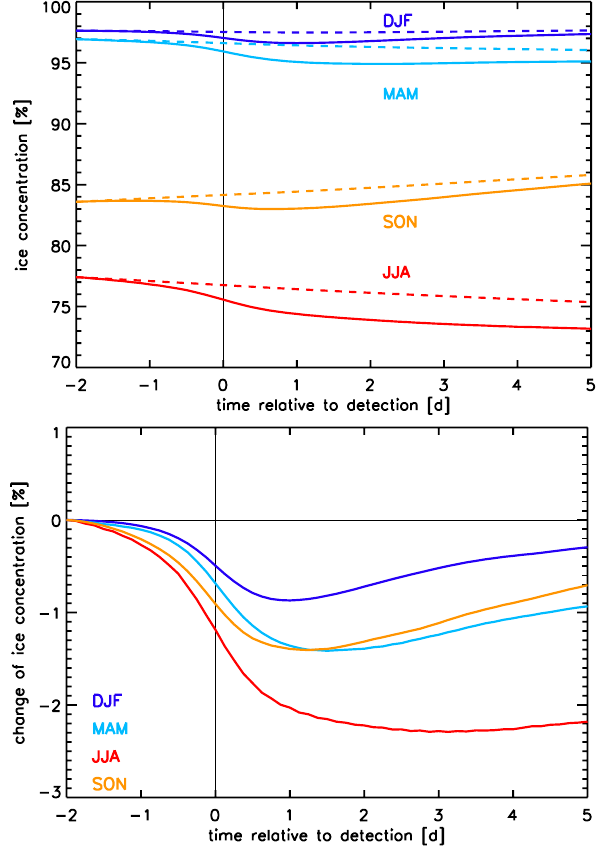
Fig. 12. Top: ice concentration in the period around the time of detection ( t = 0). Solid line: mean over all detections within the cyclone radius, dashed line: simultaneous ice concentration in the whole study area (shifted to the starting value of the correspond- ing ice concentration within the cyclone radius). Bottom: detrended change in ice concentration, relatively to t = − 2d.